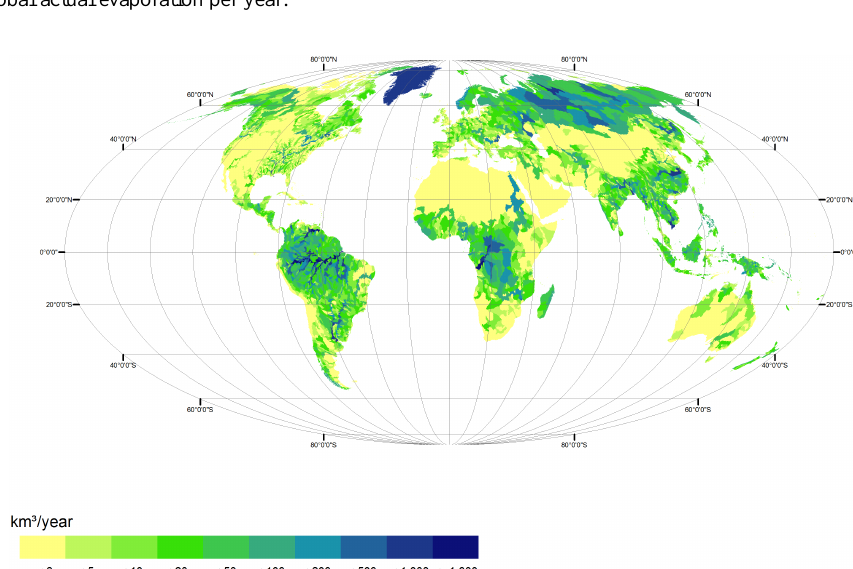
Figure 3. Average global actual evaporation per year.